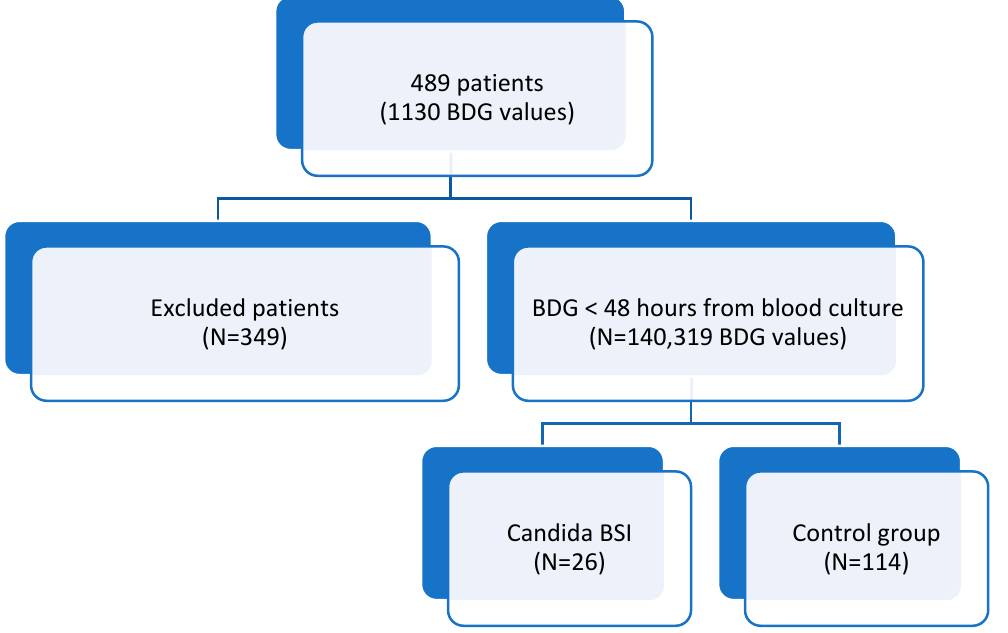
Figure 1. PRISMA flow diagram for included patients.